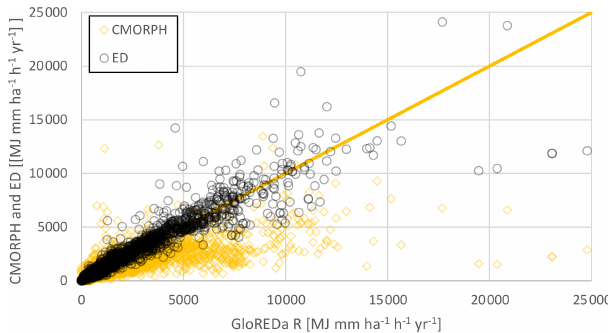
Figure 8. Comparison between local (i.e., grid cell values) long- term annual rainfall erosivity from CMORPH and ED and stations’ values of